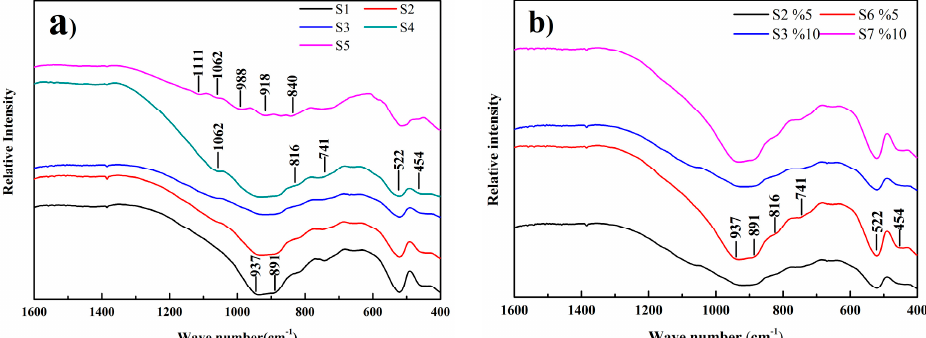
Figure 5. FT-IR spectra for the eco-cement clinkers: ( a ) clinkers with different amounts of SS additions; and ( b ) clinkers with different amounts of SS and CG additions.